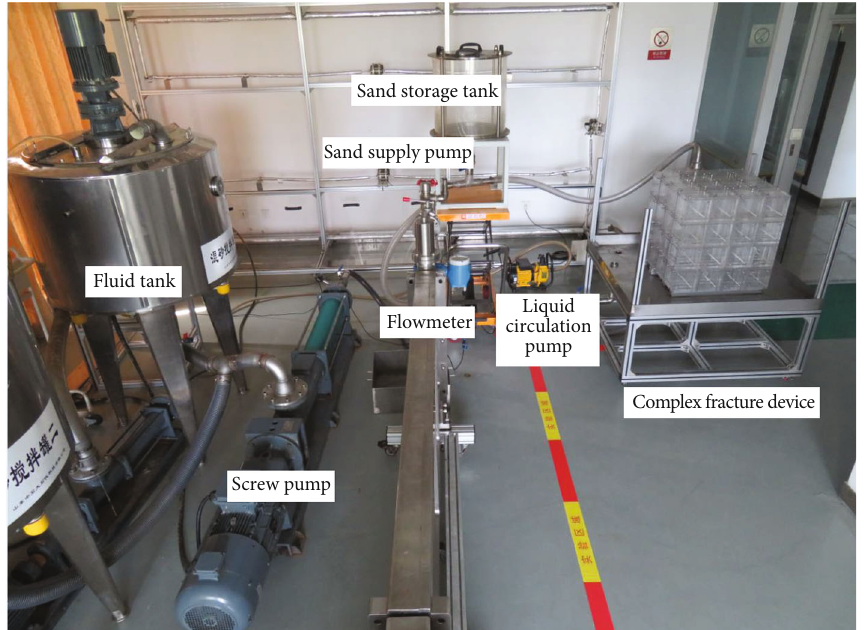
Figure 7: The overall appearance of the experimental device of proppant transport characteristics in complex fractures.